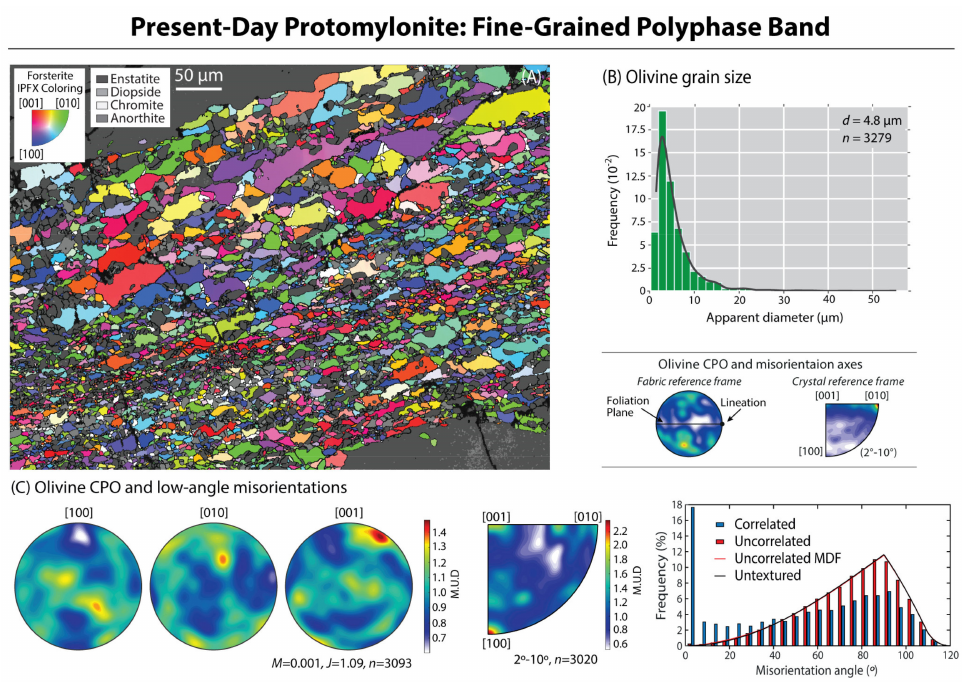
Figure 4. Microstructure results from a polyphase band in the present-day protomylonite. The location of the EBSD map is shown in Figure 3A. ( A ) Combined EBSD phase and inverse pole figure (IPF) map illustrating the microstructure of the polyphase band. The inverse pole figure map of olivine crystallographic axis orientation is colored relative to the lineation, which is parallel to the upper edge of the map (IPF-X coloring). Black lines correspond to grain boundaries. Black areas correspond to zero solutions (not-indexed domains). Step size is 0.8 µ m. ( B ) Frequency distribution of olivine grain size calculated as the equivalent circular diameter from the map in ( A ). ( C ) Crystallographic preferred orientation (CPO), distribution of low-angle misorientation axes, and misorientation angles distribution for olivine in the polyphase